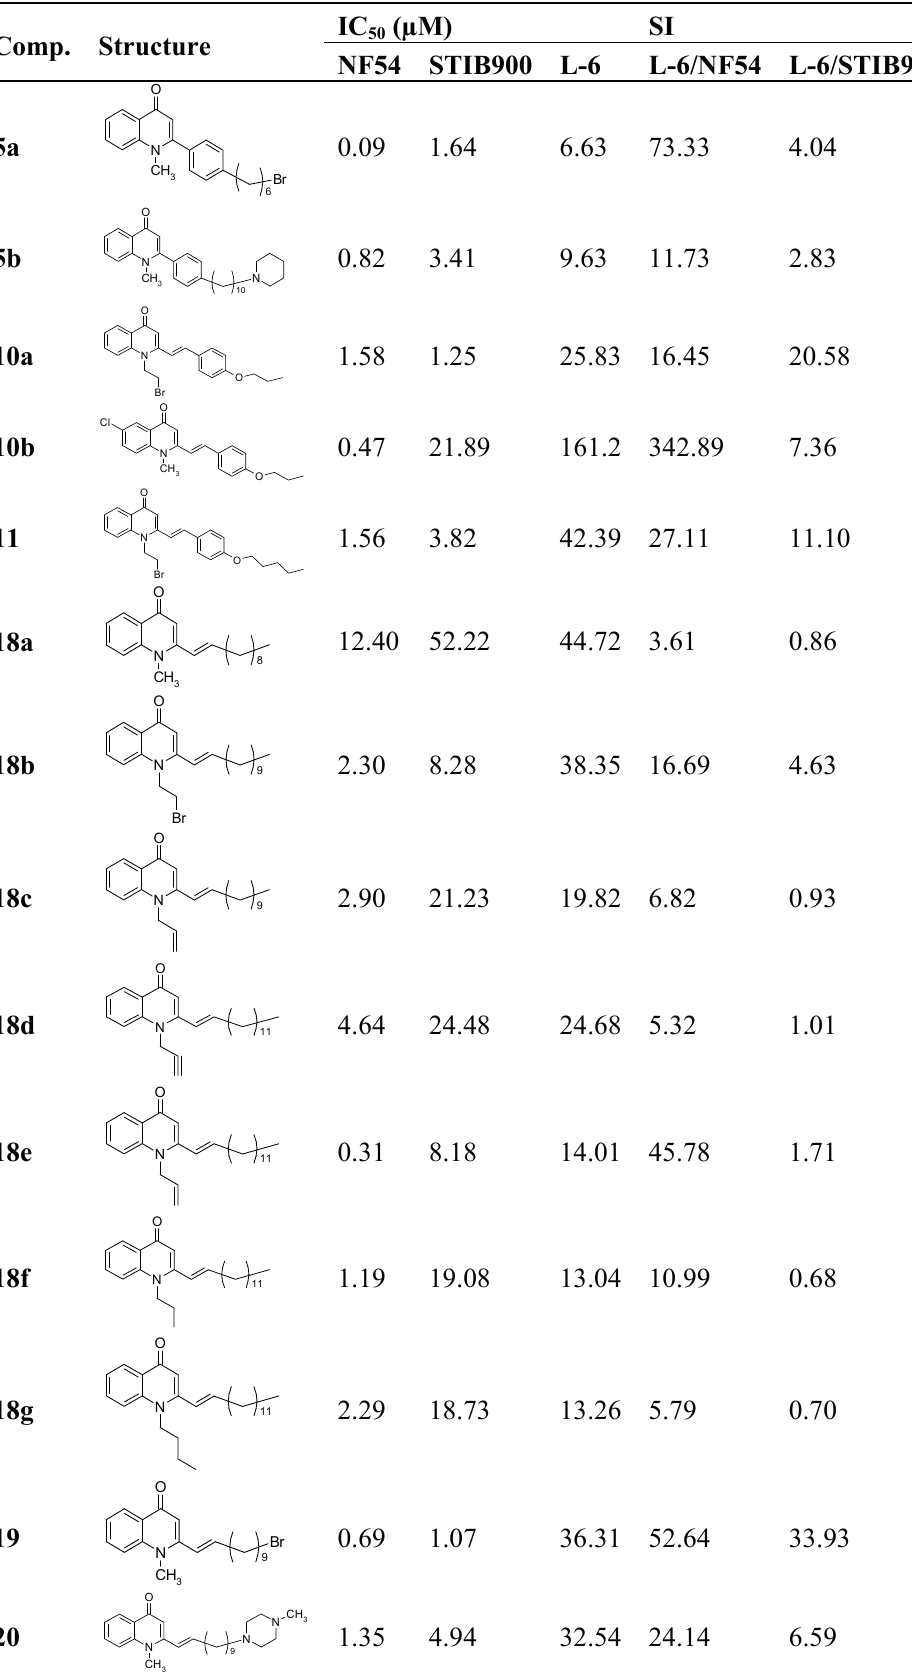
Table 1. Antimalarial, antitrypanosomal and cytotoxic activities of 4-(1 H )-quinolone derivatives.